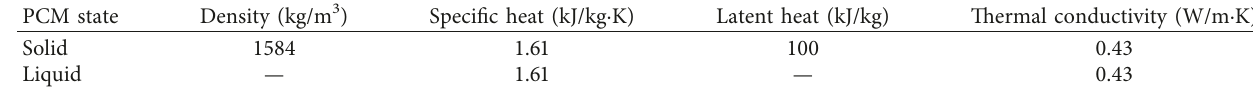
Table 1: Thermophysical properties of the salt hydrate S44